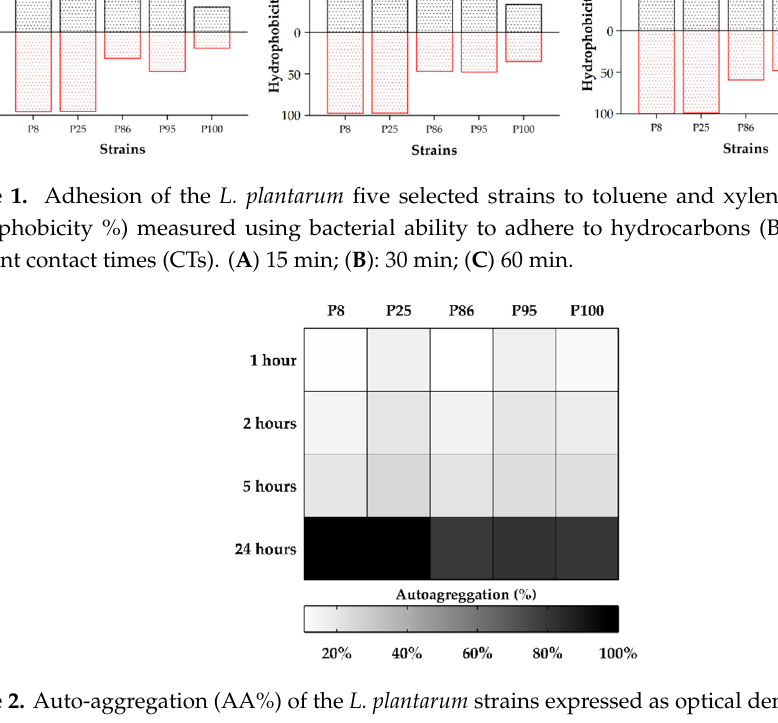
Figure 1. Adhesion of the L. plantarum five selected strains to toluene and xylene (expressed as hydrophobicity %) measured using bacterial ability to adhere to hydrocarbons (BATH) test after different contact times (CTs). A : 15 min; B : 30 min; C : 60 min.